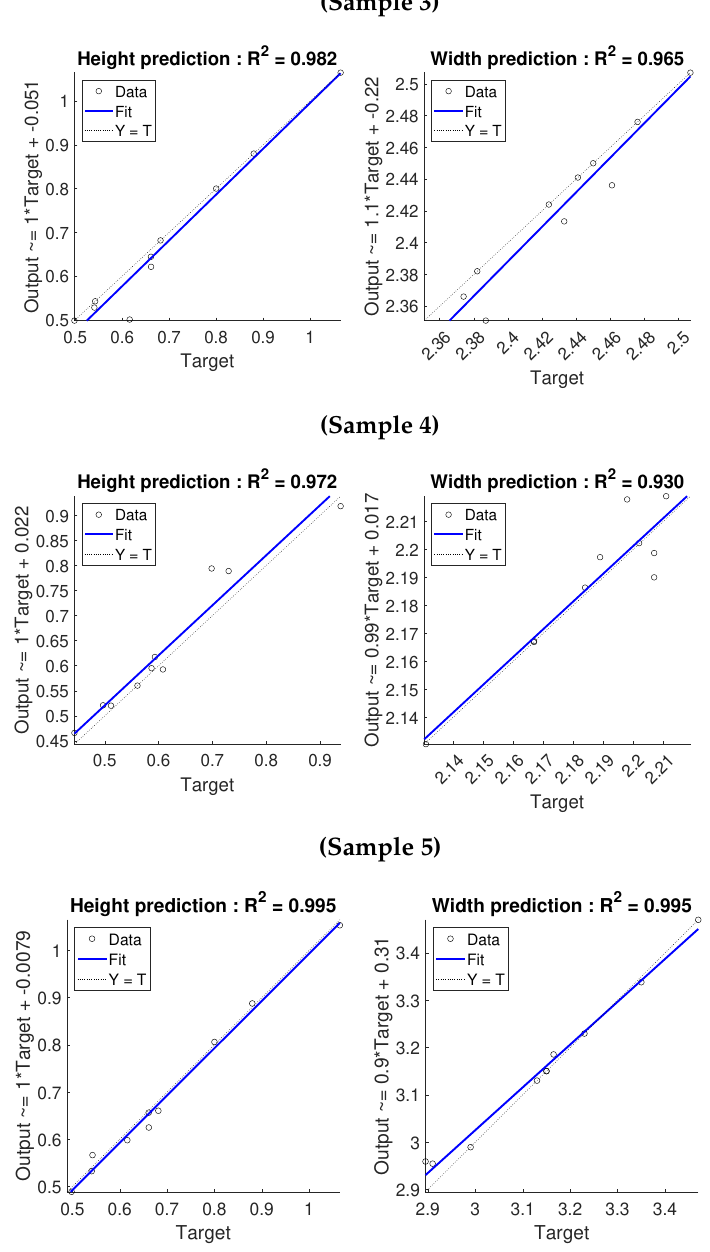
Figure 13. Regression plot for different samples prediction. Table 3. Influence of the deposition